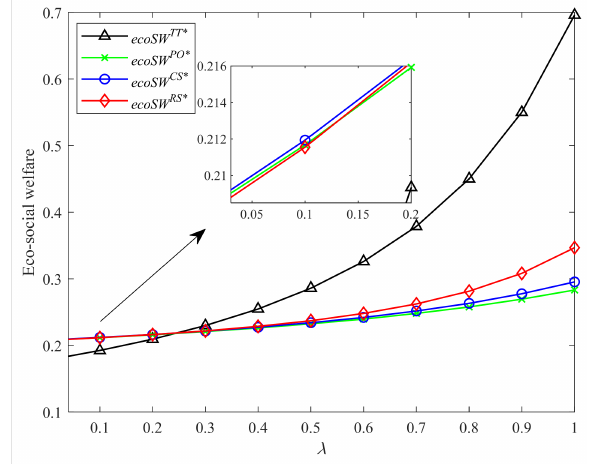
Figure 8. Comparison of eco-social welfare with different λ .